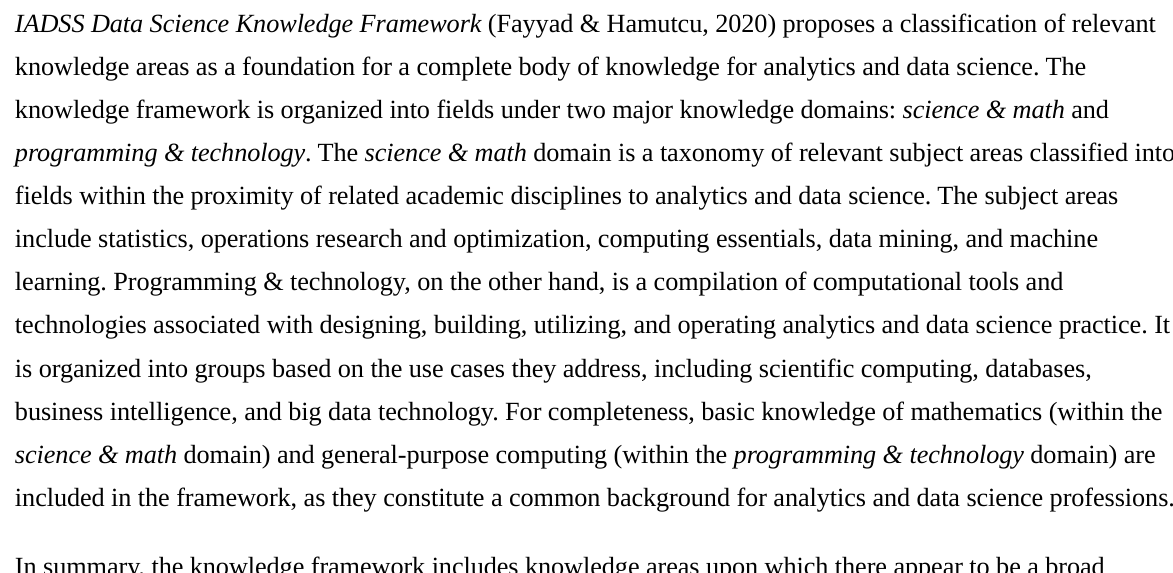
Table 1: Top-10 titles among survey